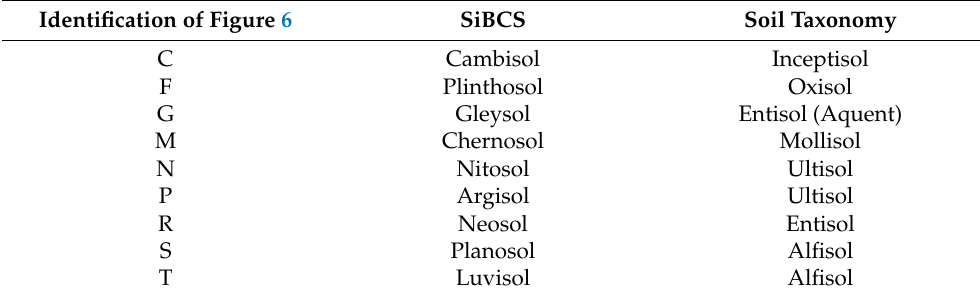
Table 5. Soil classes where the field plants were distributed, according to the Brazilian System of Soil Classification (SiBCS) and US Soil